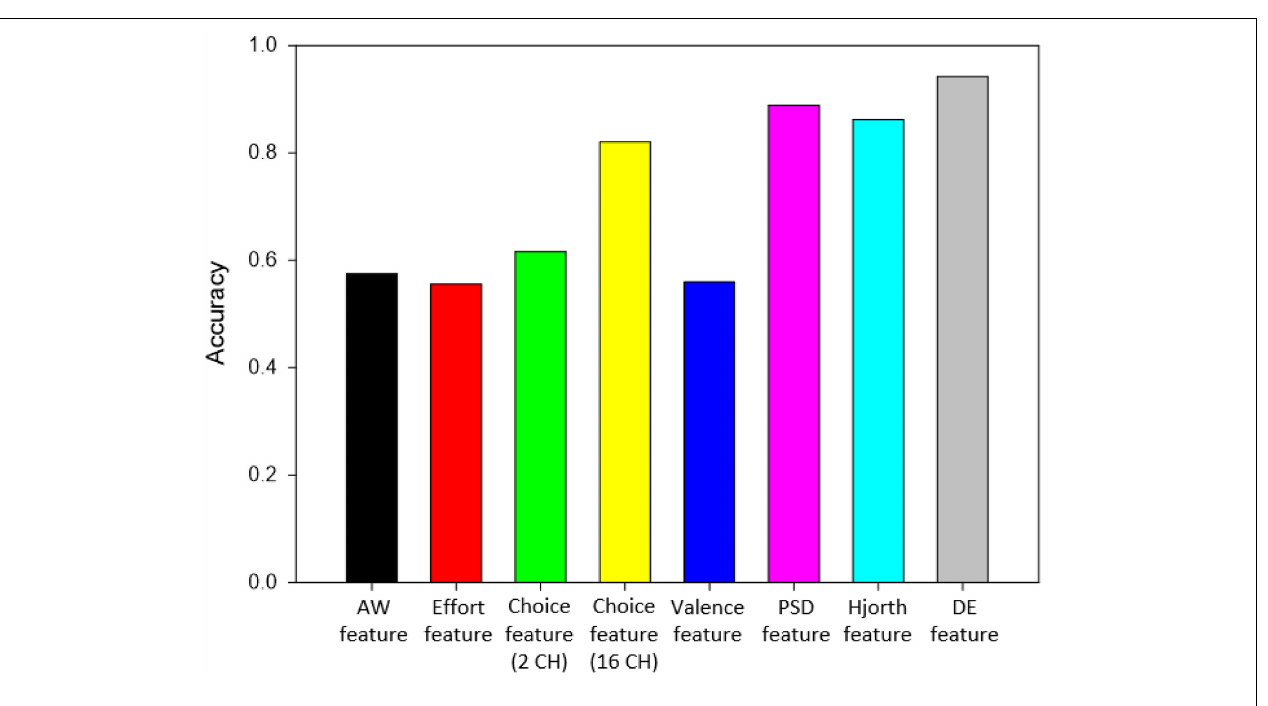
FIGURE 10 | Classification accuracy of different EEG